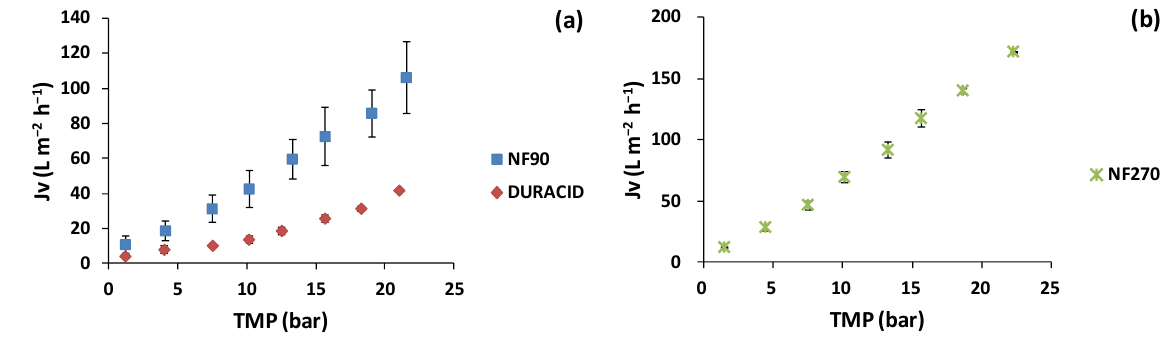
Figure 2. Variation in the trans-membrane flux as a function of TMP for ( a ) lees filters with NF90 and Duracid membranes and ( b ) olive pomace extracts with NF270 membrane.